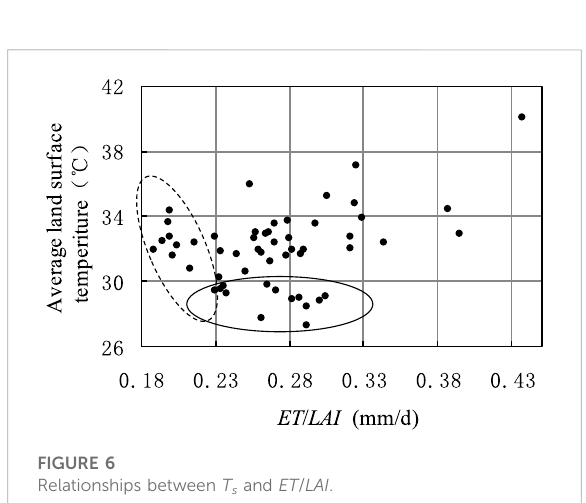
FIGURE 4 Distributionofvegetationqualityperpixel;theareaofasingle pixel is 900 m 2 .